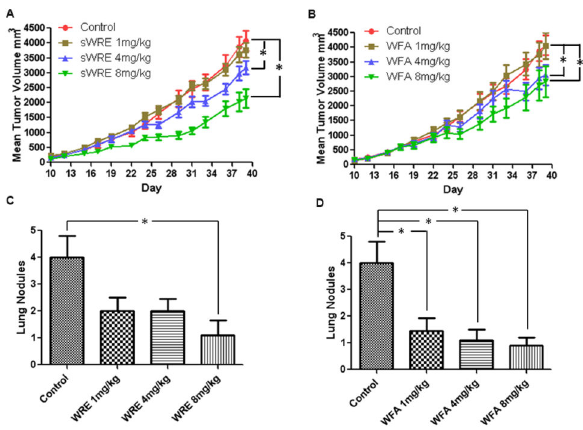
Figure 7. Anti-metastatic activity of sWRE and Withaferin A in an MDA-MB-231 xenograft breast cancer model. (A and B) Mean tumor volume in mice treated with 1, 4, 8mg/kg of (A) sWRE or (B) WFA (*, p<0.05 compared to vehicle control). Bar graph showing the mean number of metastatic lung nodules in (C) sWRE or (D) WFA-treated mice compared to vehicle control (9% EtOH; * indicated p<0.05 compared to control).